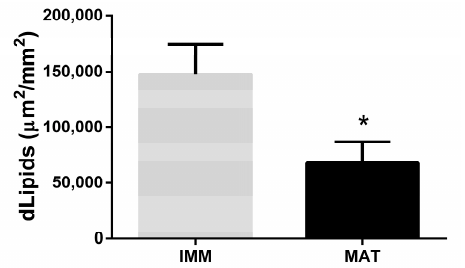
Figure 11. Difference in lipid density between livers of immature ( n = 22) and mature ( n = 28) females. Asterisk (*) indicates a significant statistical difference for p -value < 0.05.